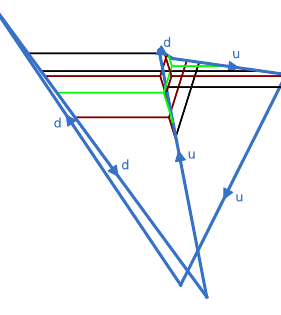
Figure 43 . Another polygonal unknot L in M = R 3 . Notation is as in figure 42. Again we show all BPS strings which can attach to L . In this case there are 4 exchanges (black), 3 three-leaf webs (dark red), and 1 four-leaf web (lime green). (This example was found by randomly generating polygons in R 3 with 6 vertices until we found one which has exactly one four-leaf web and only 11